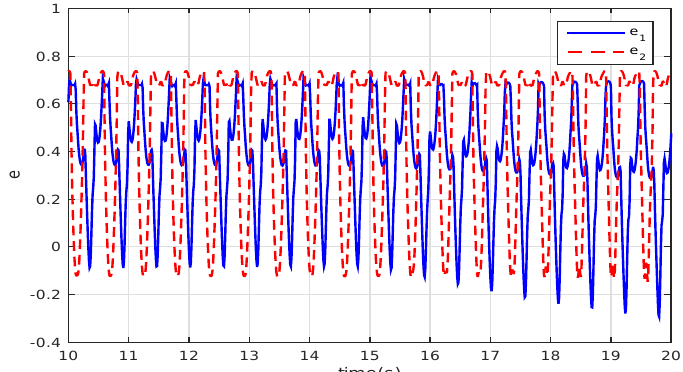
Figure 10. The feedback of the virtual spindle.